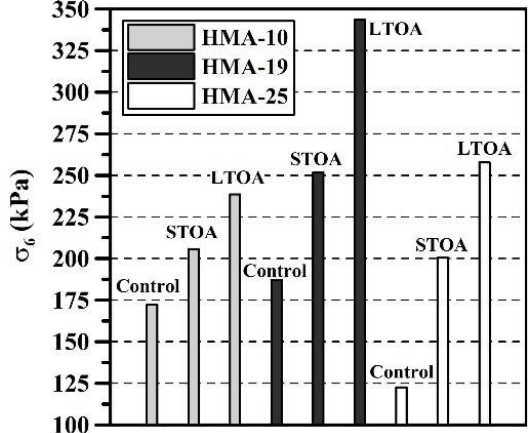
Figure 9.  6 of control mixes, STOA and LTOA. Figure 9. σ 6 of control mixes, STOA and LTOA. Table 4. Ratio between N f of control mixes, STOA and LTOA.